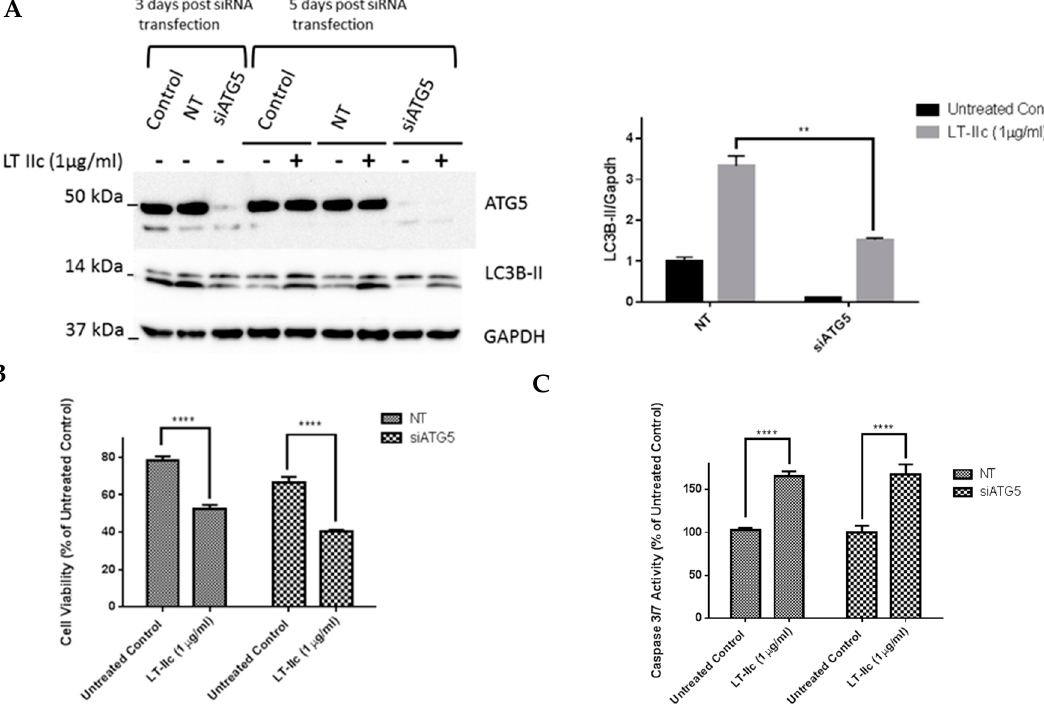
Figure 10. ATG5 gene knockdown using siRNA does not reverse LT-IIc effect on cytotoxicity or LC3B-II levels in MDA-MB-231 cells. ( A ) MDA-MB-231 cells were cultured in six-well plates prior to transfection with either ATG5 specific siRNA or a negative control NT siRNA. Three days post-transfection, ATG5 knockdown was confirmed using Western blotting. At day 5, another set of cells was treated with LT-IIc for 24 h to assess the requirement for ATG5 on LT-IIc-mediated increase in LC3B expression. The blots were quantified using ImageJ software. ( B ) Following the confirmation of ATG5 knockdown, the cells were cultured in 96-well plates prior to treatment with 1 µg/mL LT-IIc for 48 h. Cell viability was assessed using MTT assay, as described previously. ( C ) Following the confirmation of ATG5 knockdown, the cells were cultured in 96-well plates prior to treatment with 1 µg/mL LT-IIc for 24 h. Caspase 3/7 activity was determined using the fluorescent apo-One homogenous caspase 3/7 activity assay, as described above. All experiments are representative of at least two independent experiments. Error bars represent SEM. Key: ** p < 0.01, **** p < 0.0001. Three days post-transfection, MDA-MB-231 cells with confirmed ATG5 knockdown were